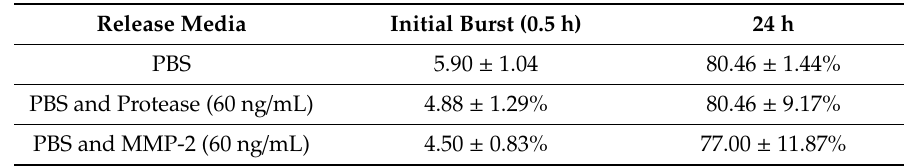
Figure 2. ( A ) Release points at 0.5, 3 and 6 h, deviation marks have been removed in order to permit its appreciation ( B ) Cumulative in vitro release (percentage) of TM for 96 h (5 days) with three different release media PBS, PBS with protease (60 ng/mL) and PBS with MMP-2 (60 ng/mL). Each experiment was carried out by quadruplicate. Table 2. Initial burst and release at 24 h TM-NPs in the di ff erent release media employed (PBS, PBS with protease and PBS with MMP-2).